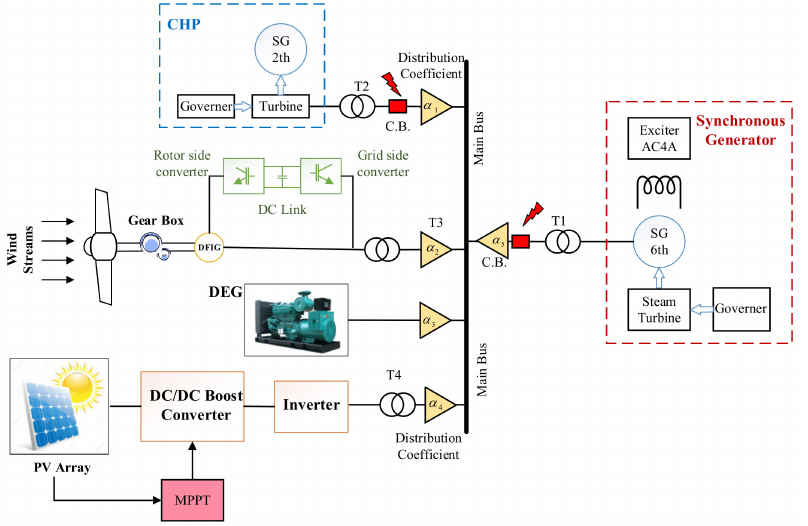
Figure 9. The layout of hybrid MG connected to a power system using distribution coefficients in frequency excursion